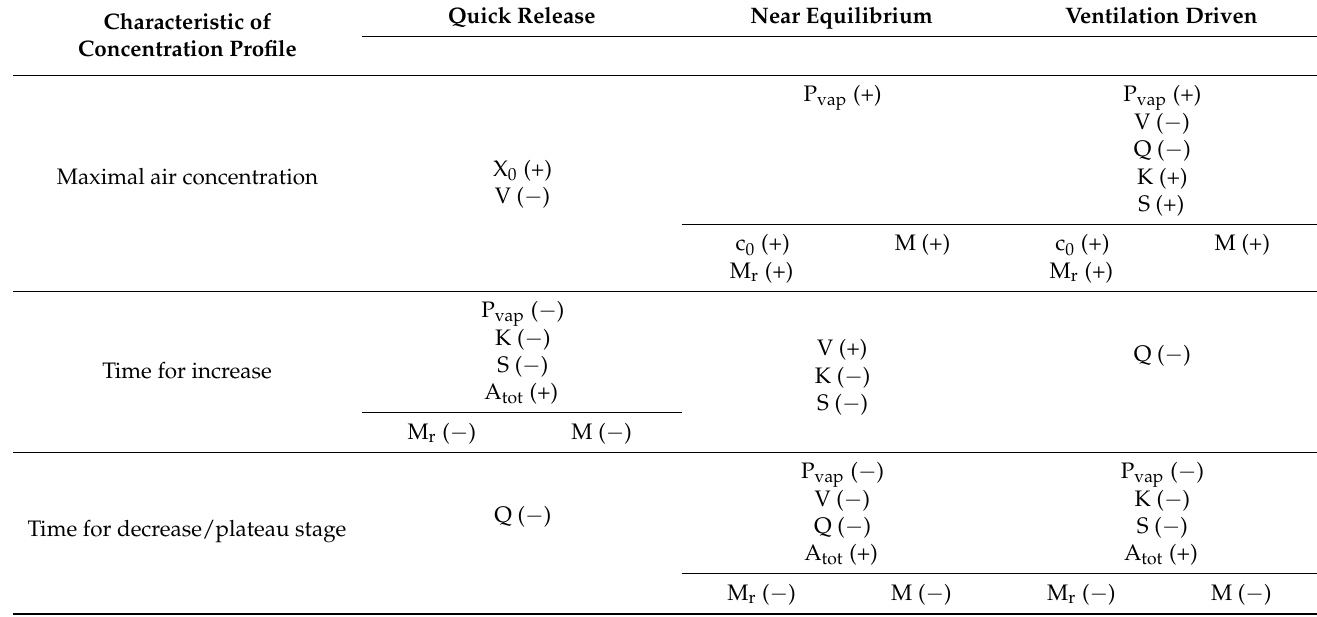
Table 1. List of sensitive parameters according to the chosen variable and boundary case. (+) denotes linear (positive) dependence, ( − ) denotes an inverse relationship. Cells that are divided list the parameters on the left for the small concentration approximation, while the right one is for pure substance. The lowest row refers to the time for decrease in case of the small concentration approximation and the plateau stage for pure substance (except for the quick release, where the plateau stage does not exist). Quick Release Near Equilibrium Ventilation Characteristic of Concentration Profile